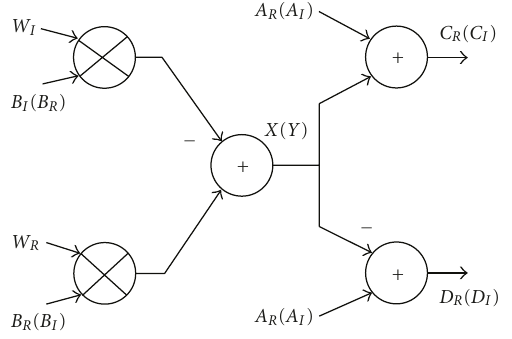
Figure 6: Rescheduled data flow graph for the radix-2